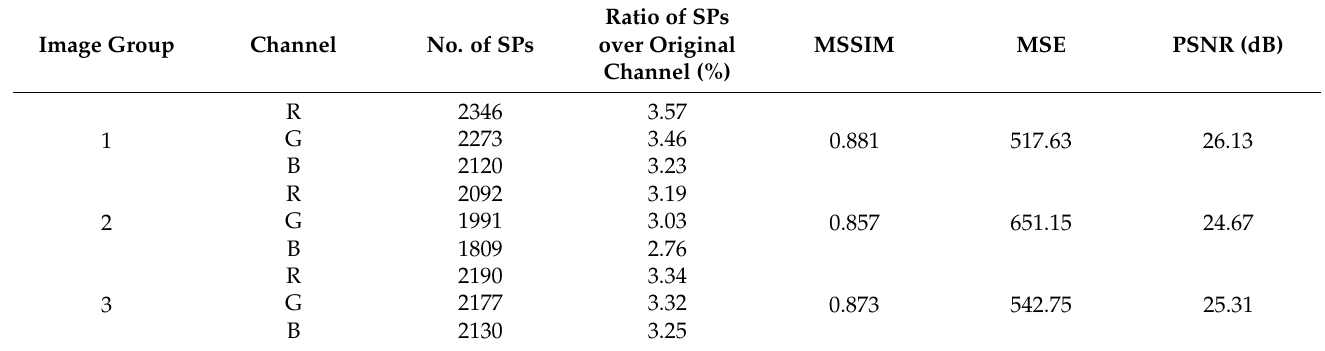
Table 6. MSSIM, MSE, and PSNR values of the proposed IR-DWT-CGAN.